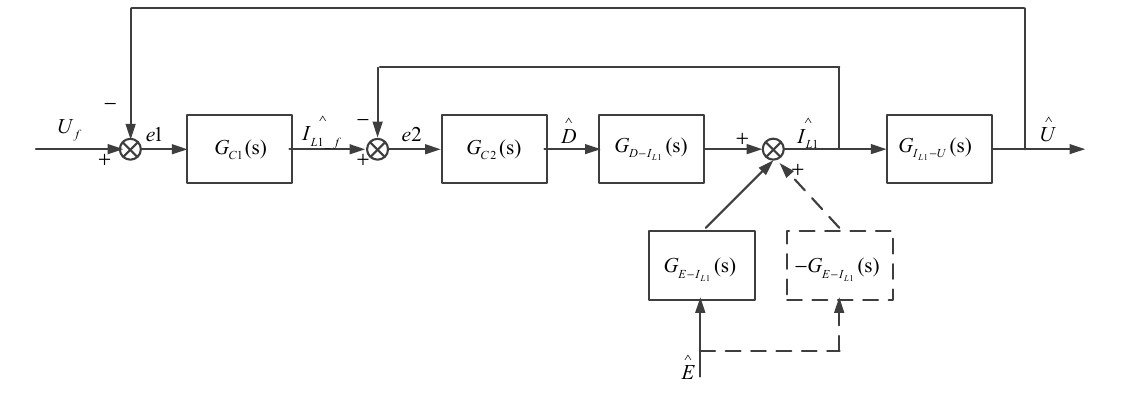
Figure 9. Dual feedback control flow chart for input voltage compensation.